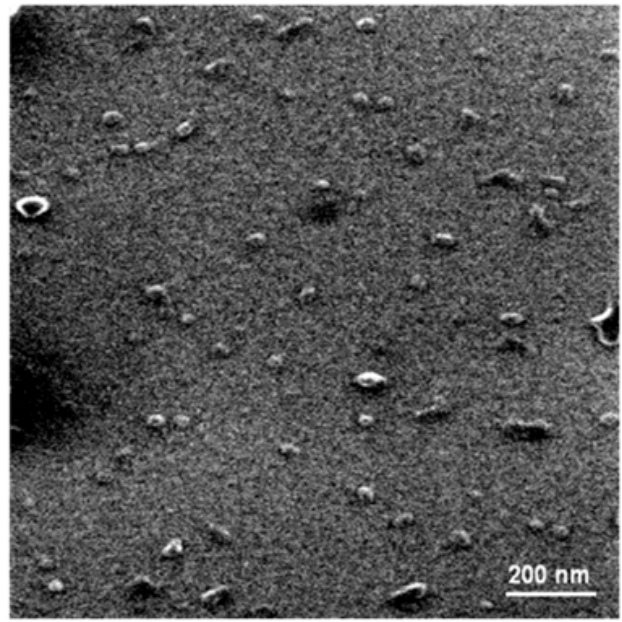
Figure 1. TEM micrograph NanoMIPs specific for florfenicol.